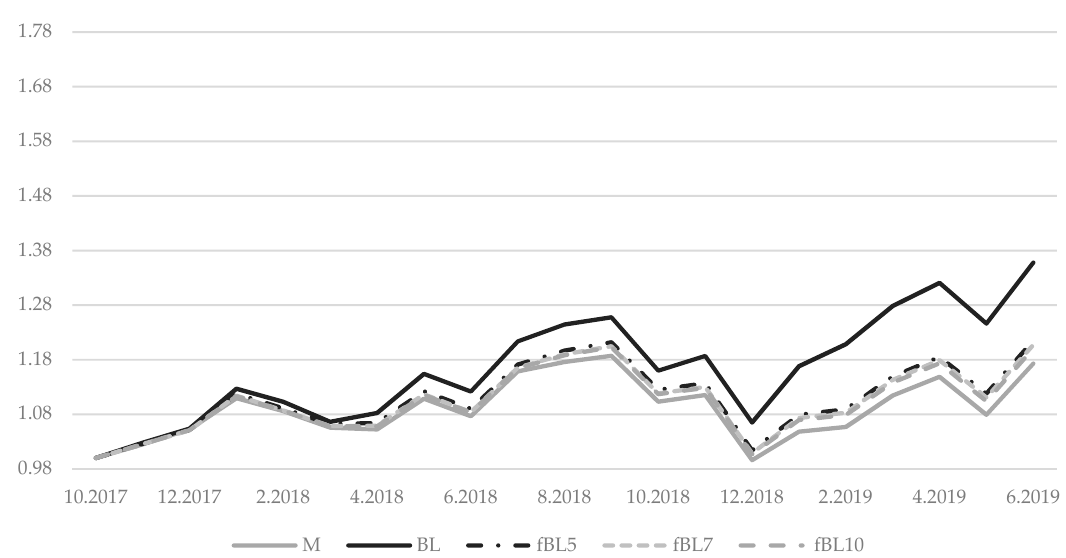
Figure 5. Average investment performance without short sale.